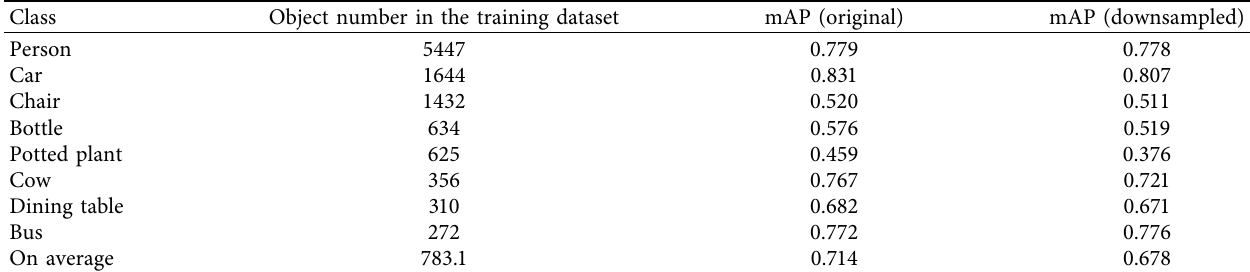
Table 9: Comparison of detection results based on the original training dataset and downsampled dataset (the average values are computed for the twenty